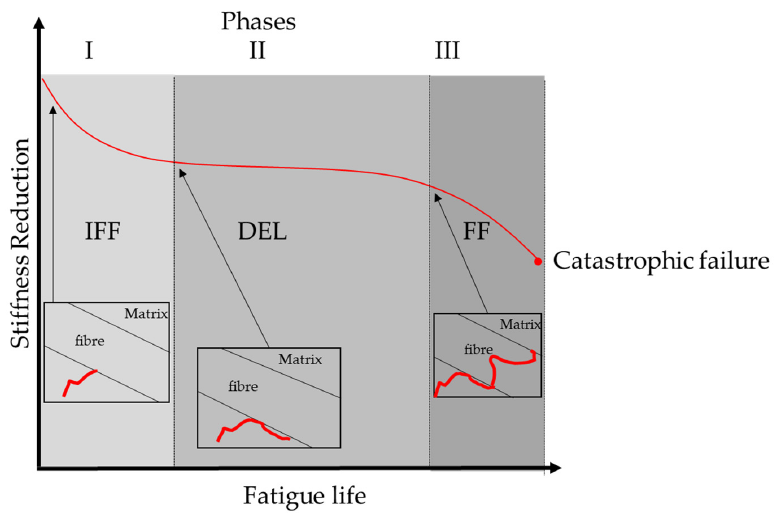
Figure 1. Fracture behaviour under cyclic loading of CFRP and CFRP-Veil, where the red lines represent crack propagation within the composite laminate. Phase I, inter fibre failure (IFF); Phase II delamination (DEL); Phase III fibre failure (FF).